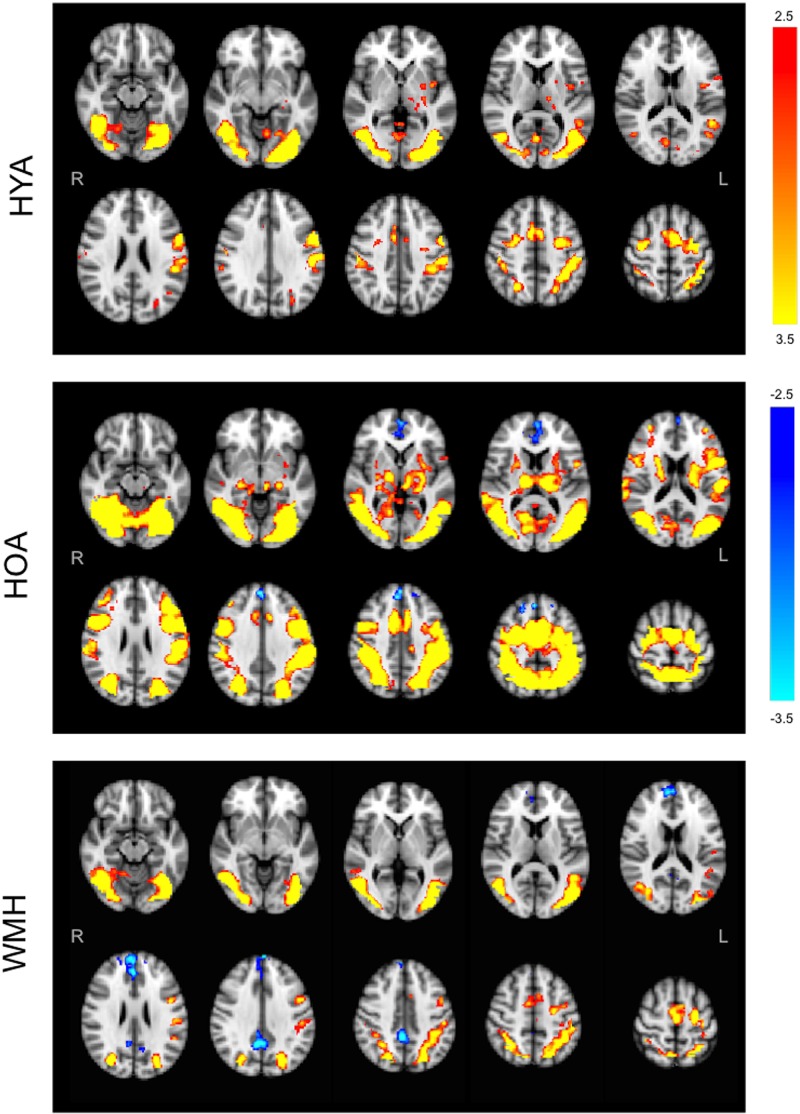
Group average statistical maps of BOLD fMRI signal for all versus baseline condition. HYA activated bilateral sections of the visual and attention networks like the anterior cingulate gyrus, occipital cortex, left insula, parietal opercular, and parietal lobes, and supplementary motor cortex, with no evidence of deactivation. HOA activated the visual and attention networks including fronto-parietal areas, insula, and lateral occipital cortices, with deactivation in the frontal pole, cingulate and paracingulate. WMH demonstrated tightly localized activity in the attention system (middle frontal), with deactivation throughout interoceptive network nodes (frontal regions and precuneus). Primary threshold for all maps was Z = 2.32 and cluster-correction threshold was P = 0.05. Warm colors, activation relative to fixation. Cool colors, deactivation relative to fixation.